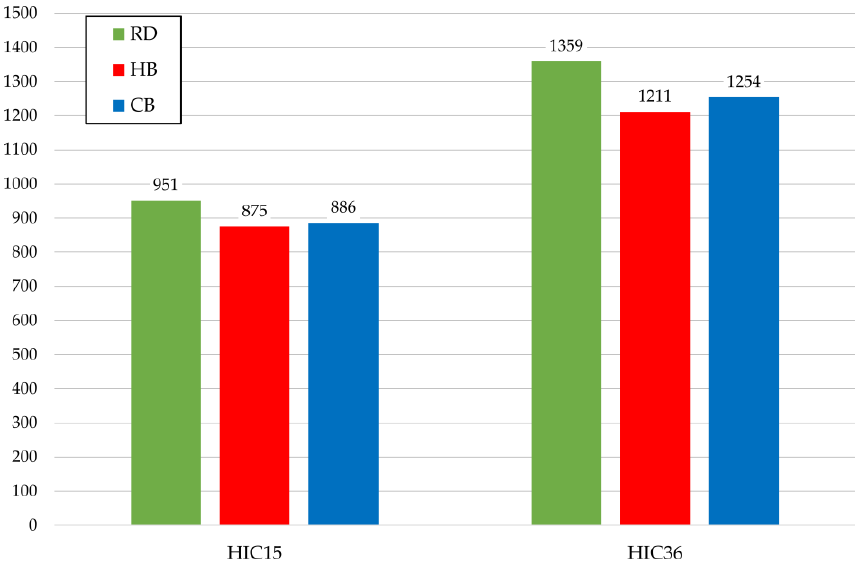
Figure 17. Head Injury Criterion (HIC) comparison.